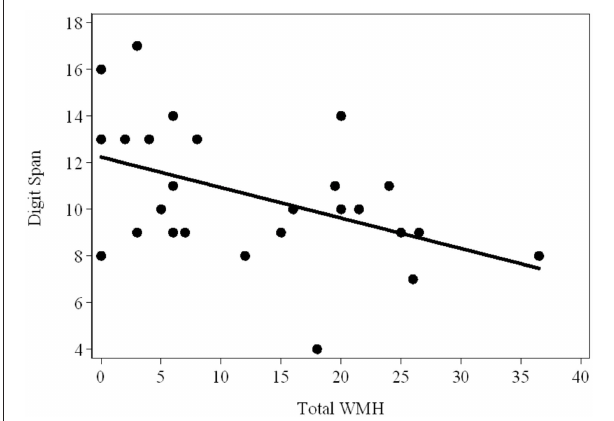
FIGURE 2 | Scatterplot showing the (raw) Total Digit Span scores against the WMH scores in the total sample (FXTAS and Non FXTAS combined) of PM